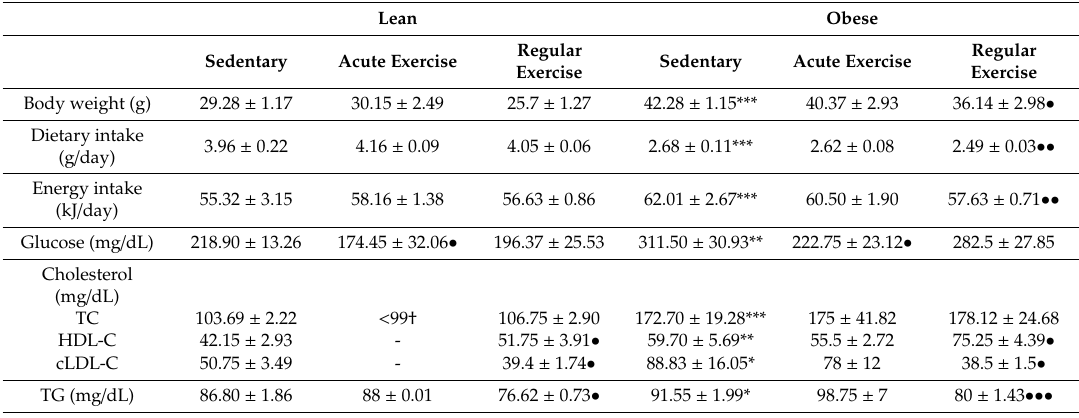
Table 1. Body weight, dietary and energy intake, and metabolic parameters in lean and obese